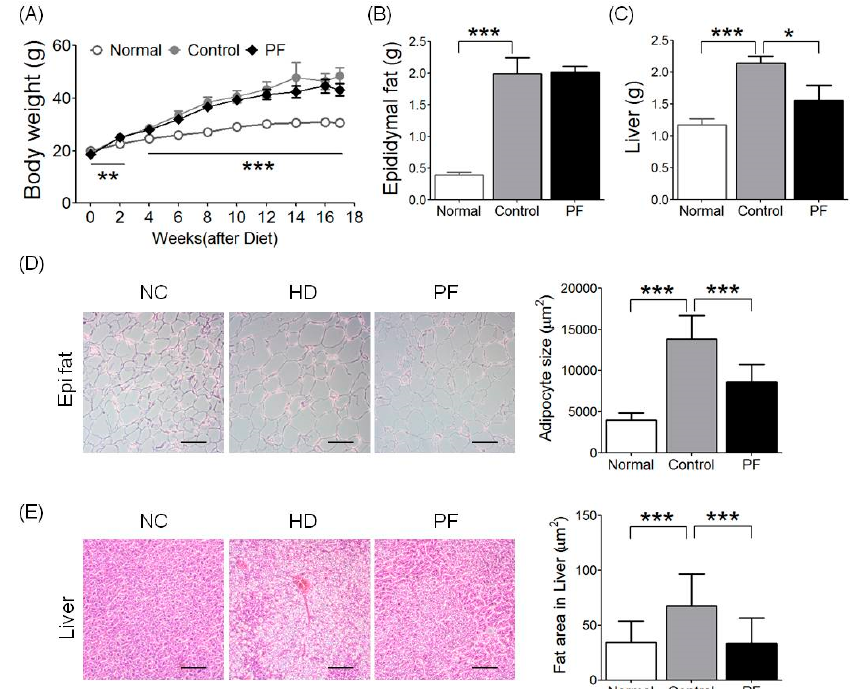
Figure 1. Effects of Poncirus fructus (PF) on ( A ) body weight, ( B ) epididymal fat, ( C ) liver weight, and ( D and E ) histological changes in epididymal fat and liver. Representative histological images were assessed by hematoxylin and eosin (H&E) staining, scale bar indicates 100 µ m. ( D ) Adipocyte size in epi fat and ( E ) adipocyte size and fat area in liver. n = 6 in each group. Data shown are the mean ± standard error of the mean (SEM). * p < 0.05, ** p < 0.01, *** p < 0.001, compared with high-fat diet